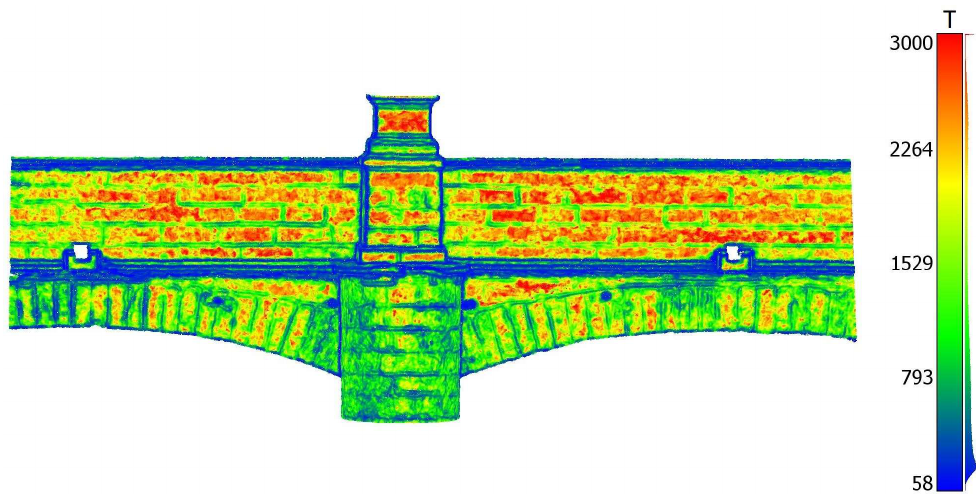
Figure 4. Data 1—The original point cloud colored according to the T values; red—flattest parts, blue—most curved/rugged parts.